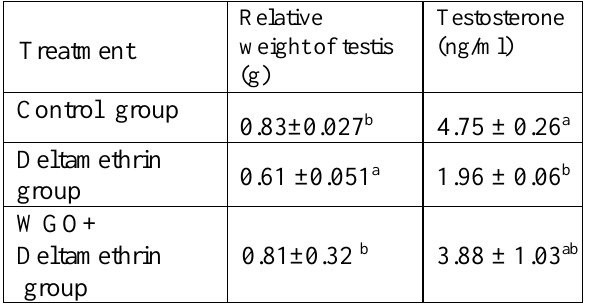
Table 4: DNA fragmentation percentages: